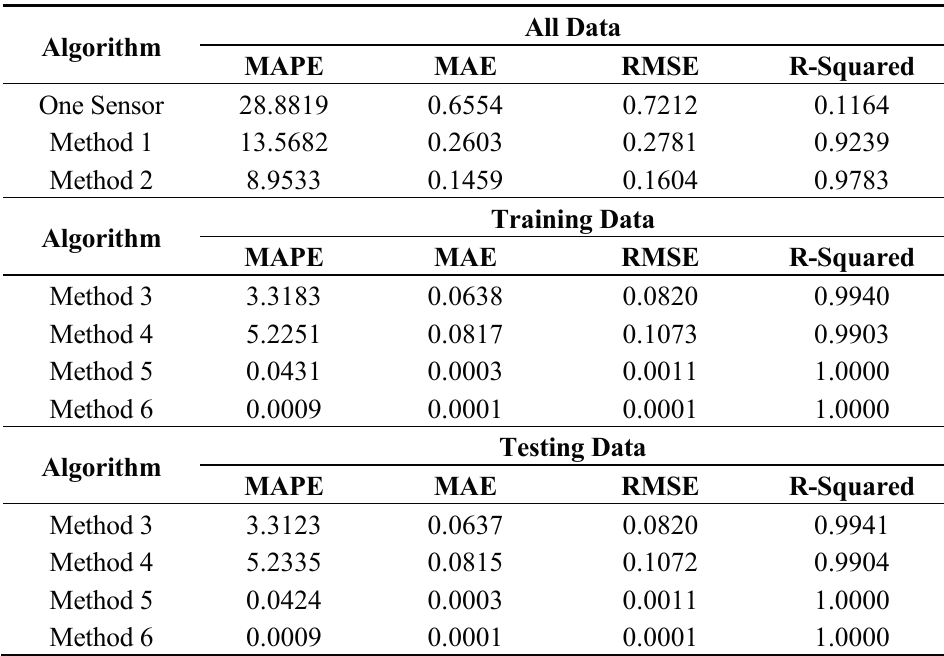
Table 4. Experiment result by kaolin solution in the pilot